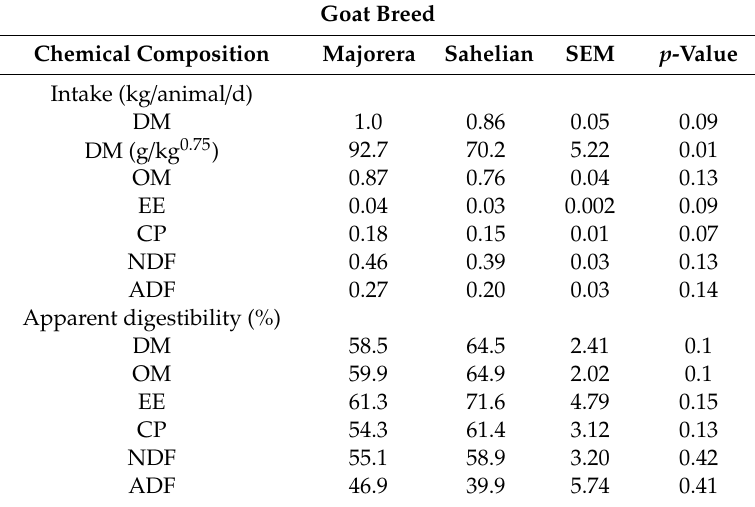
Table 2. Dry matter, chemical component intake and apparent digestibility (%) in lactating goats from Majorera and Sahelian breeds fed cowpea fodder. Goat Breed Chemical Composition Majorera Sahelian